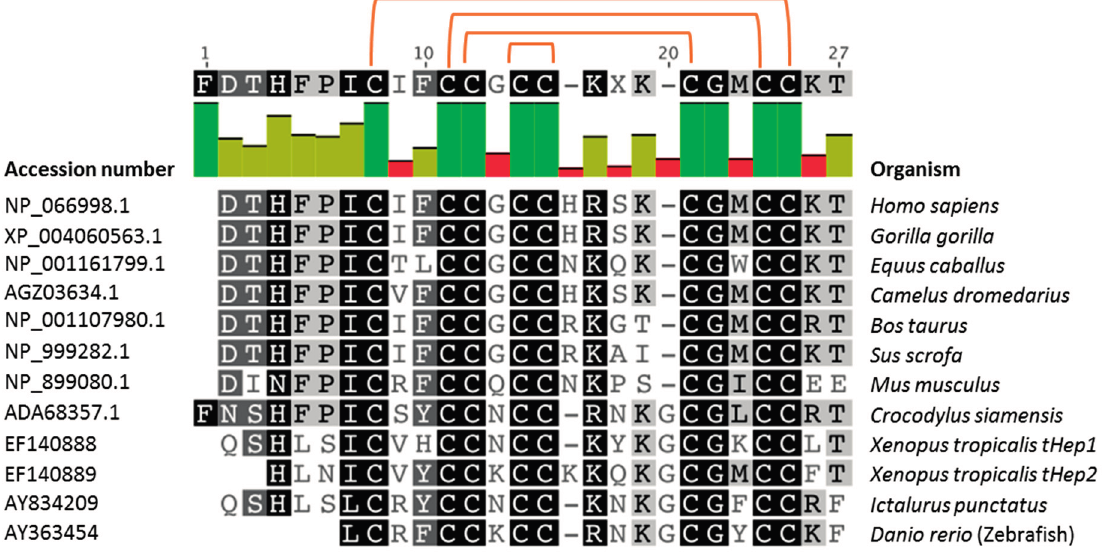
Figure 2. Comparison of mature hepcidin amino acidic sequence in different